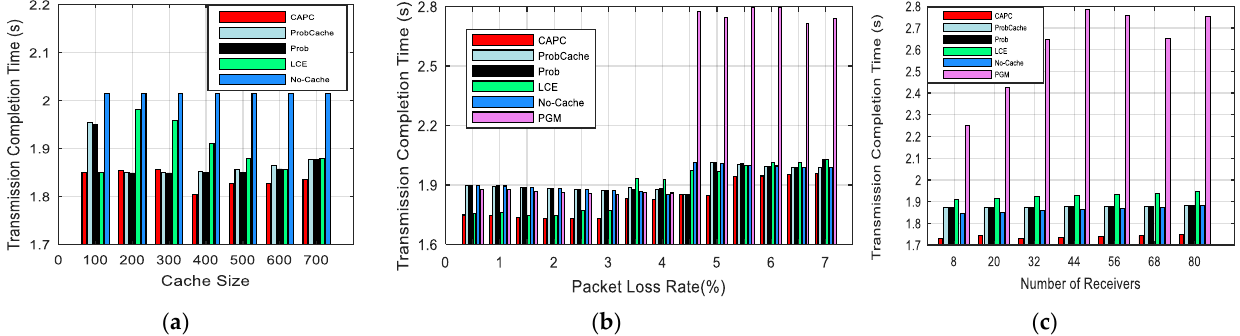
Figure 9. The comparison of average transmission completion time. ( a ) The comparison of average transmission completion time under different cache sizes; ( b ) the comparison of average transmission completion time under different packet loss rates; ( c ) the comparison of average transmission completion time under different numbers of receivers.